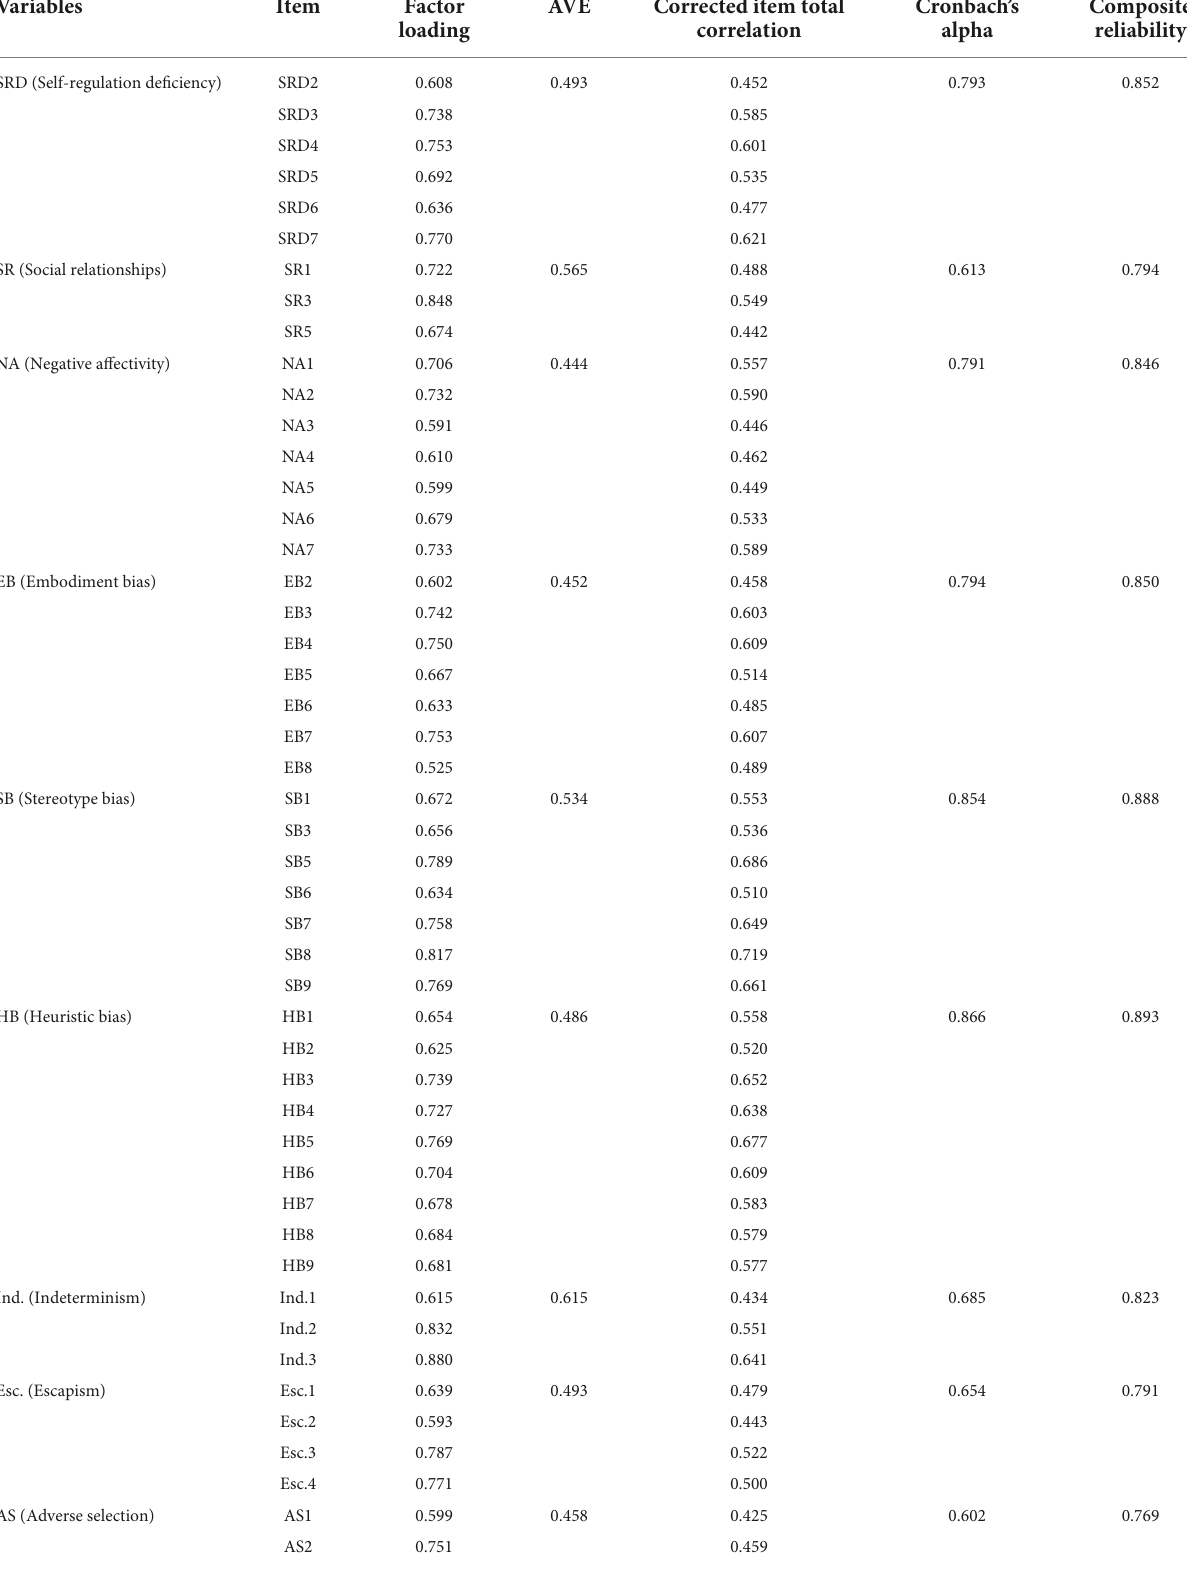
TABLE 3 Validity and reliability test